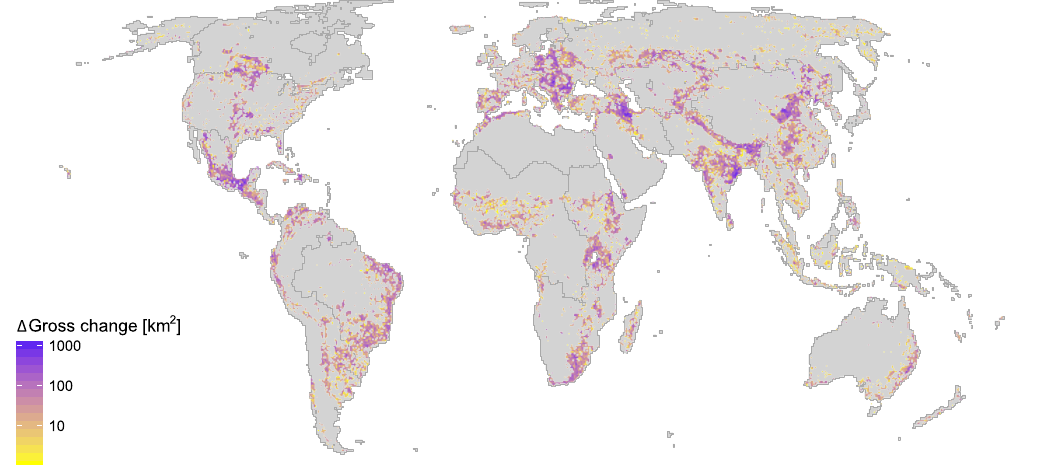
Figure 3. Difference between gross versus net area affected by change at grid cell level (ca. 0.5 ◦ × 0.5 ◦ ) as shown by one realization of a single LUCM (CLUMondo; FAO 3 demand scenario). Areas affected by net or gross change have been accumulated over a 40-year simulation period (2000–2040). Net changes are calculated at ca. 0.5 ◦ × 0.5 ◦ resolution, while gross changes also account for bidirectional changes at the 5arcmin native CLUMondo resolution (Supplement Sect. S2.2; Fig. S1). Darker colors indicate a larger difference between the area changed under net and gross change views at ca. 0.5 ◦ × 0.5 ◦ grid level. Note the logarithmic